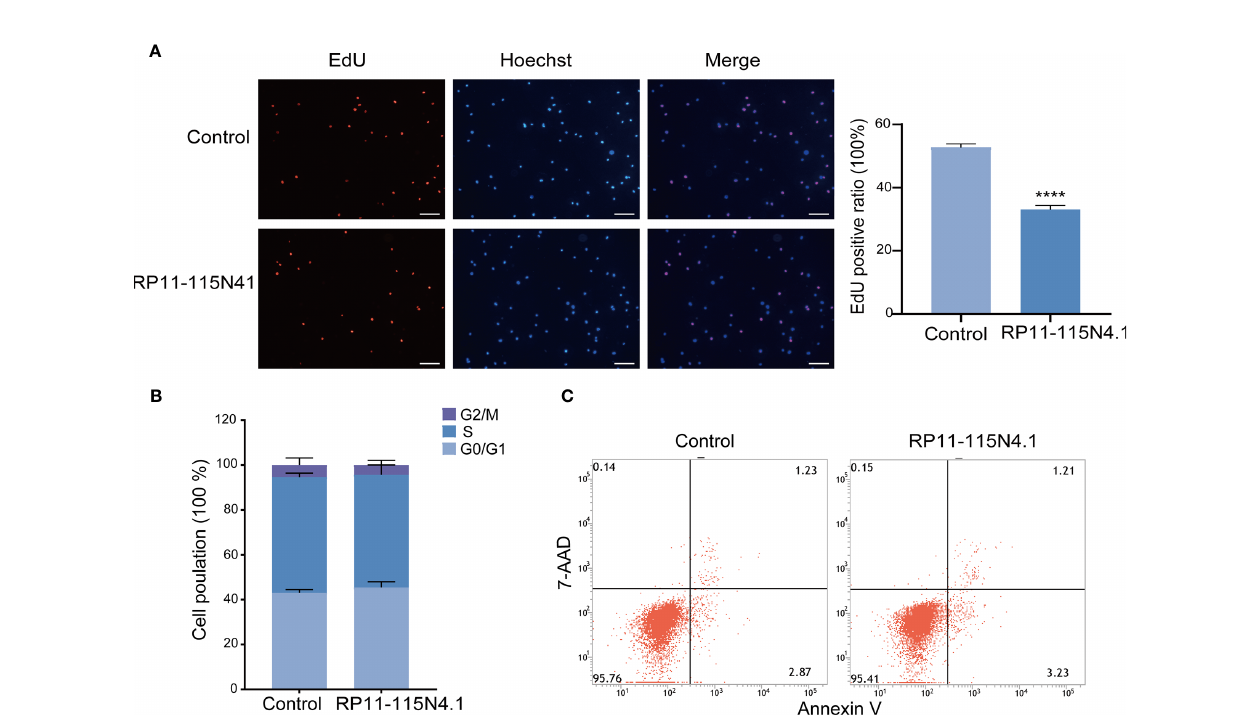
FIGURE 2 | RP11-115N4.1 overexpression signi fi cantly decreased K562 cell proliferation. (A) EdU assay for cell proliferation in K562 cells with RP11-115N4.1 overexpression. The percentage of EdU positive cells was detected by fl ow cytometry. The picture scale was 100 m m. (B) Cell cycle assay of K562 cells with RP11- 115N4.1 overexpression. (C) Cell apoptosis analysis in K562 cells with RP11-115N4.1 overexpression. **** P < 0.0001. Each experiment was repeated three times and results are means ±